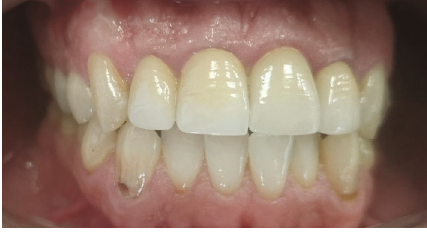
Figure 19: Clinical view after 5 years